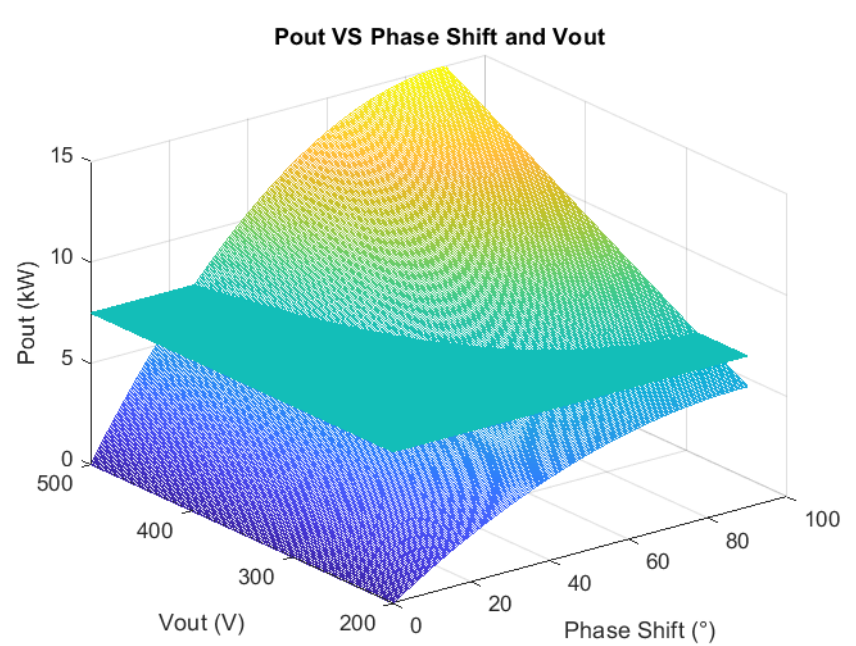
Figure 6. Output power vs. output voltage and phase shift; green threshold plane at P out = 7.5